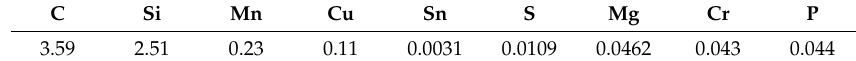
Table 1. Chemical composition of the investigated ferritic ductile cast iron (wt %), balance Fe.